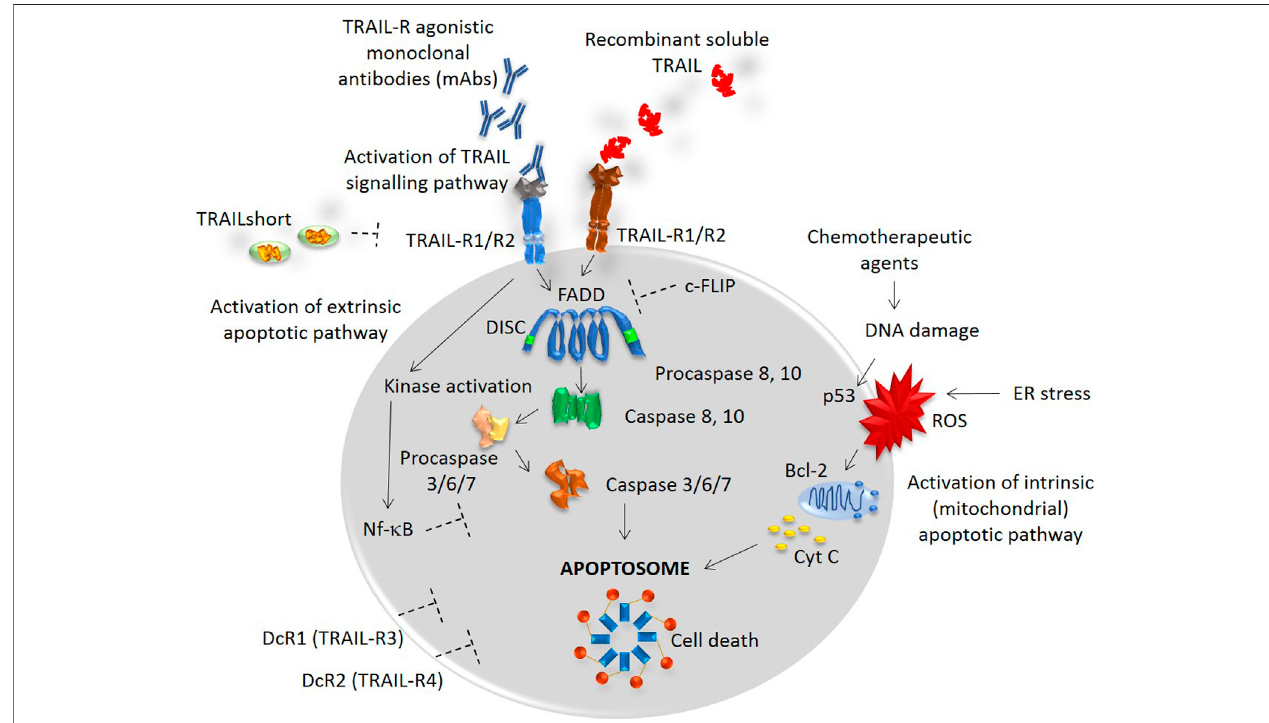
FIGURE 1 | TRAIL signalingpathway. TRAIL bindstoTRAIL-R1,R2, DcR1and DcR2 receptors witha similarly highaf fi nity. Death receptors TRAIL-R1 and TRAIL-R2 containaconserveddeathdomain(DD)motifandthus,bindingofTRAILtransmitstheapoptoticsignalbycausingatrimerizationofthereceptorandaformationofthedeath- inducing signaling complex (DISC). The recruitment of an adaptor molecule, FADD, is associated with the DISC formation and a subsequent binding and activation of caspases8and10.Thisprocessallowstheactivationofothereffectorcaspases,includingtheexecutorcaspases,caspase-3andcaspase-7,triggeringthe fi nalsteps ofapoptosis.TRAILisknowntotriggertheextrinsicapoptoticpathway,whilemultipleotherstimuli,suchaschemotherapeuticagentsorstimulicausingtheDNAdamageor ER stress, trigger the intrinsic (mitochondrial) apoptotic pathway. Depending on the cellular context, both intracellular inhibitors, such as c-FLIP and Nf-kB, and extracellular inhibitors, such as TRAILshort and DcR1/2 can restrain the caspase activation and contribute to the resistance to TRAIL-induced cell